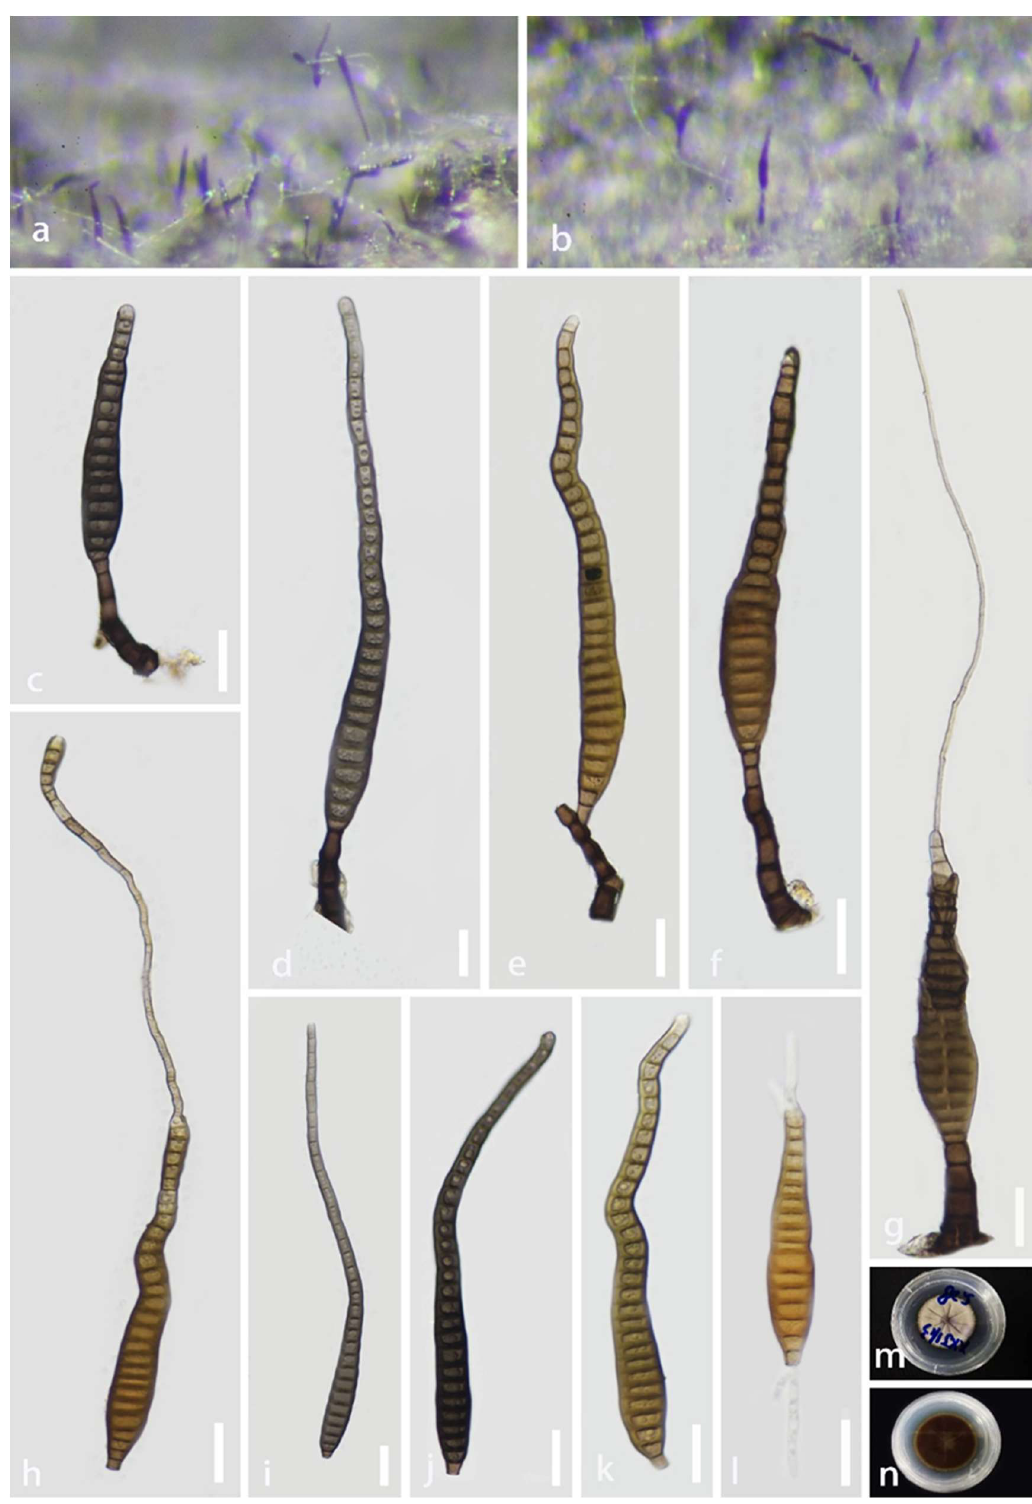
Figure 4. Distoseptispora aquisubtropica (GZAAS 22-0080, holotype). ( a , b ) Colonies on the host surface. ( c – g ) Conidiophores and conidiogenous cells bearing conidia. ( h – k ) Conidia. ( l ) Germinating conidium. ( m , n ) Colonies on PDA, m from above, n from below. Scale bars: ( c – l ) 20 μm. Distoseptispora pachyconidia R. Zhu and H. Zhang. Journal of Fungi 30: 22 (2022). Fig- ure 5. Index Fungorum Number: IF559924; Facesoffungi number: FoF12581.